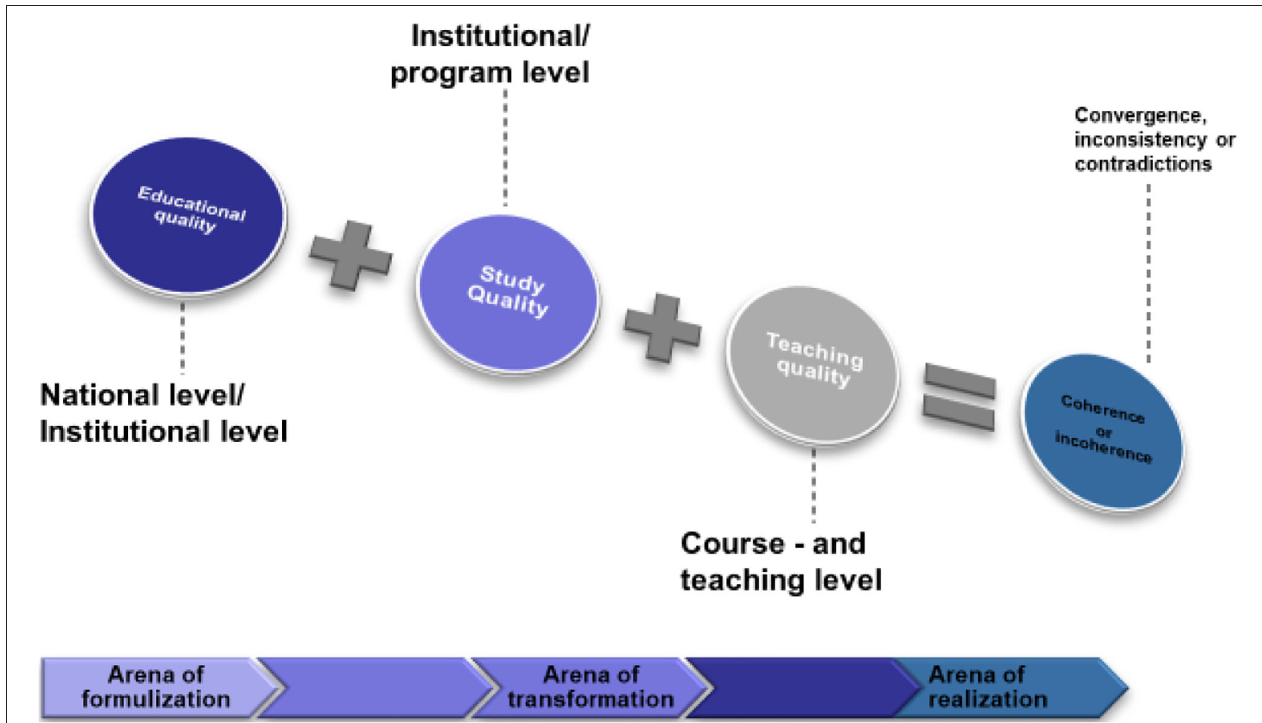
FIGURE 1 | The analytical focus in the policy and practise review (Krumsvik et al.,